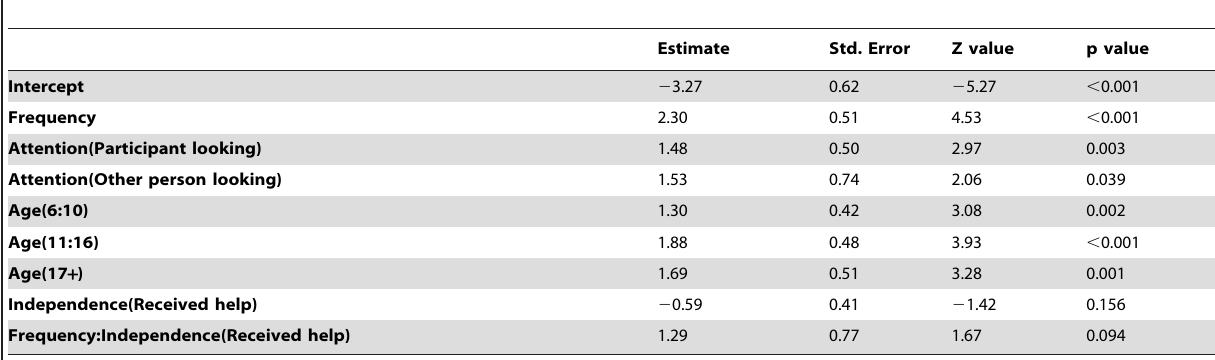
Table 4. Regression table for the best fitting model described in the text.